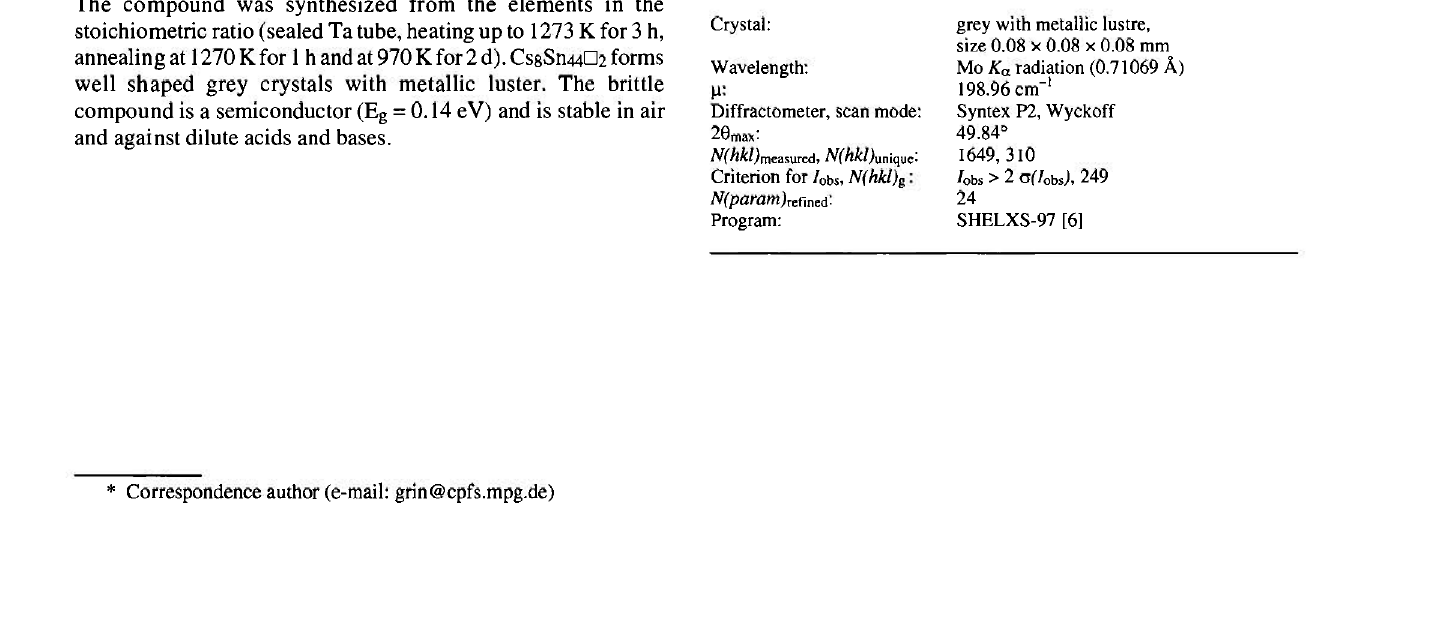
Table 1. Data collection and